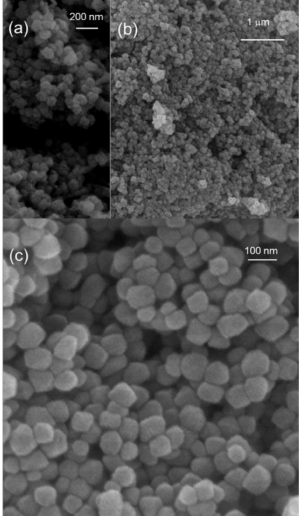
Figure 2. ( a ) SEM images of the obtained iron oxyhydroxide (goethite); ( b , c ) SEM images at different magnifications of the obtained iron oxide (hematite), FO